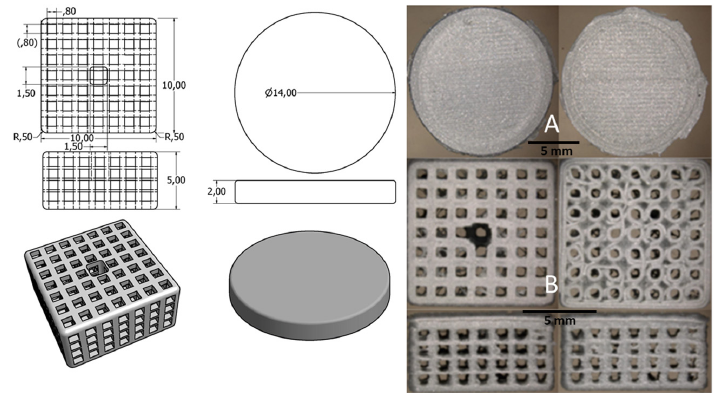
Figure 8. Left side : Technical sketches with dimensions in [mm] for both the PLA disc and the PLA cage. Right side : light microscopic pictures of the original 3D-printed objects ( A ) PLA disc, ( B ) PLA cage.